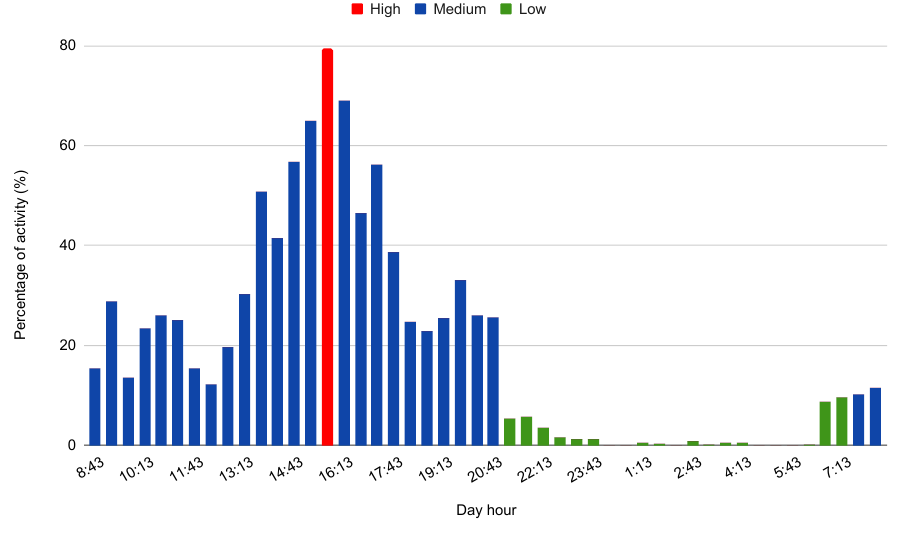
Figure 4. Server activity in 30-min time windows over a